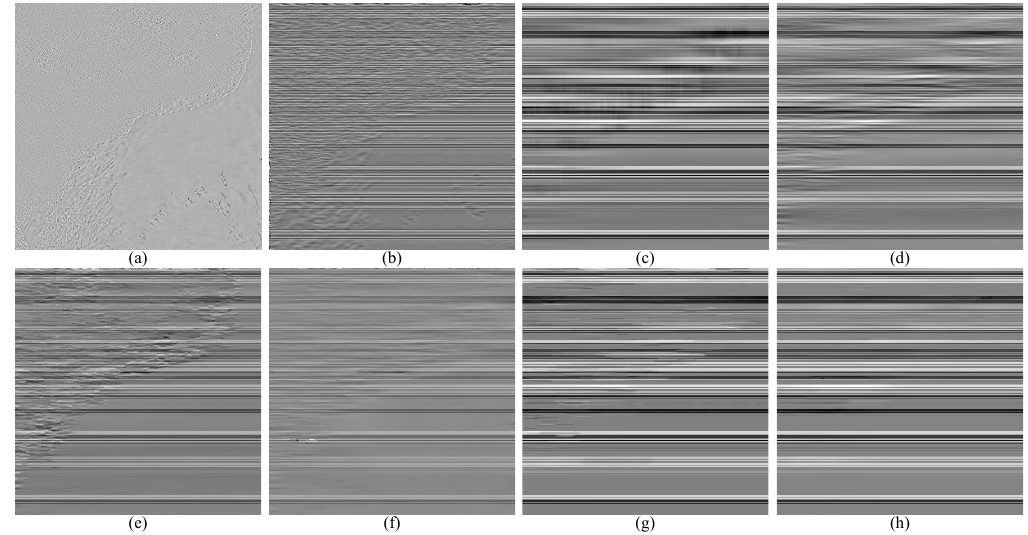
Figure 13. Noise estimation comparison results for simulated stripe Aqua MODIS data S5. ( a ) BM3D;